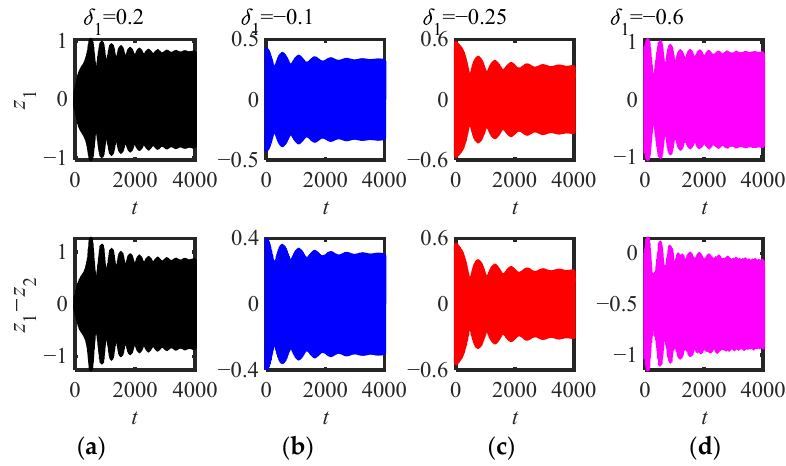
Figure 15. Time-domain response of (5) (parameters in Figure 11b m 2 = 4, μ = 2, κ = 0.1): ( a ) δ 1 = 0.2,